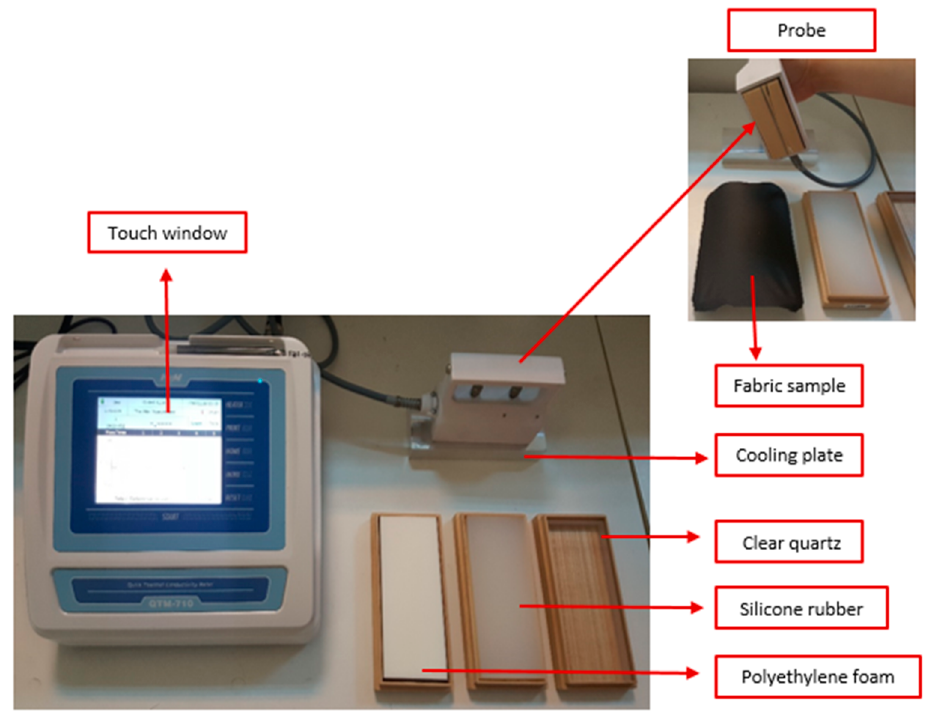
Figure 3. Thermal conductivity measurement according to the JIS R 2618 standard [19] with QTM-